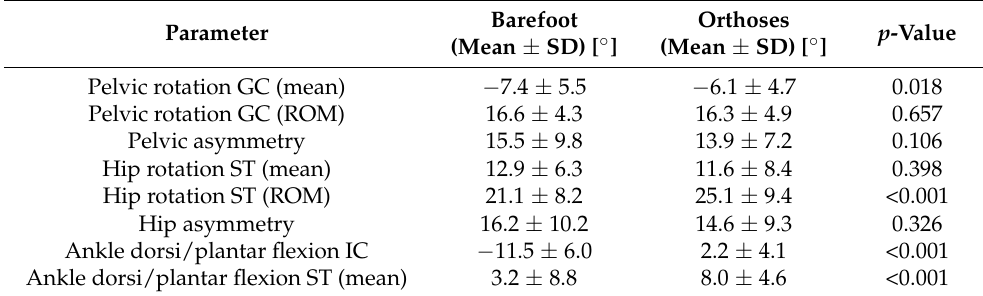
Table 2. Comparison of kinematic gait data barefoot and with orthoses.